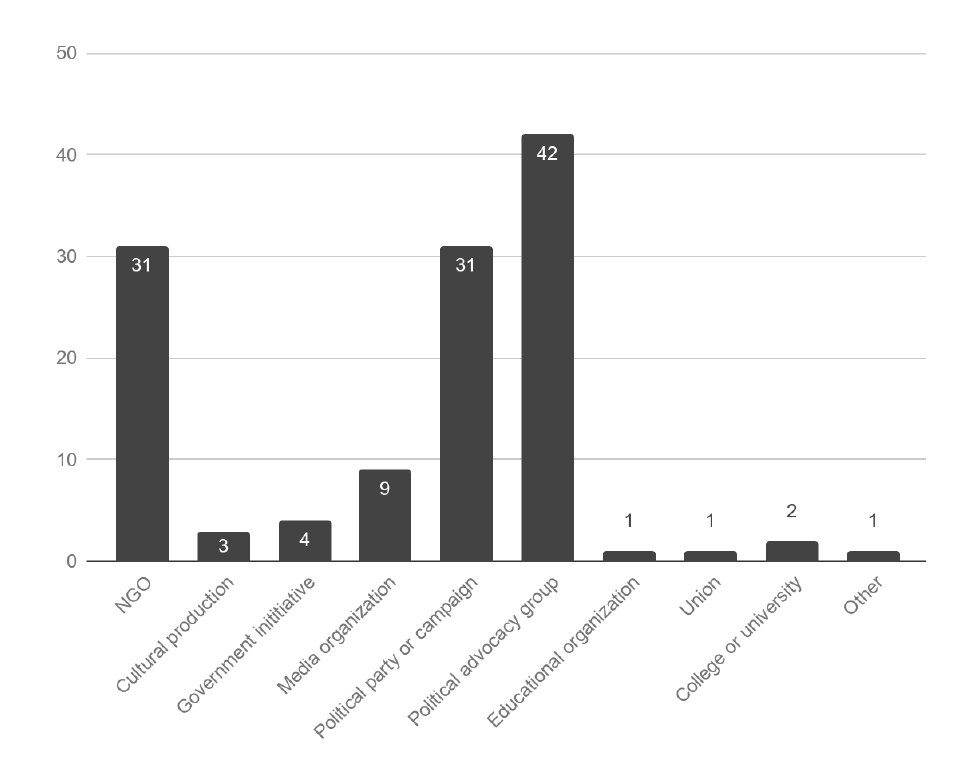
Figure 3: Sites using NationBuilder by industry Media outlets are more prominent in the findings than in 3DNA’s corporate materials. Two media outlets are in the top ten domains in our sample sorted by popularity as seen in Table 1. The third and fourth ranked sites are media organisations. Faith Family America is a right-of- centre news outlet, describing itself as “a real-time, social media community of Americans who are passionate about faith, family, and freedom”. The Rebel is a Canadian-based far-right news outlet, comparable to Breitbart in the US. Seven other media organisations appear in the sample, nine in total as seen in Table 2. Table 1: The top ten websites in BuiltWith data set, according to Alexa ranking (the lower the number, the more popular the